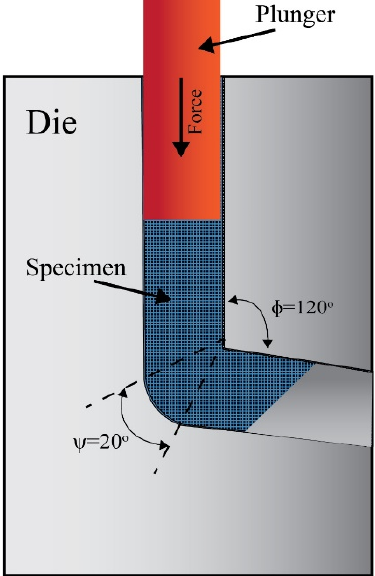
Figure 1. The schematic of the ECAP die.